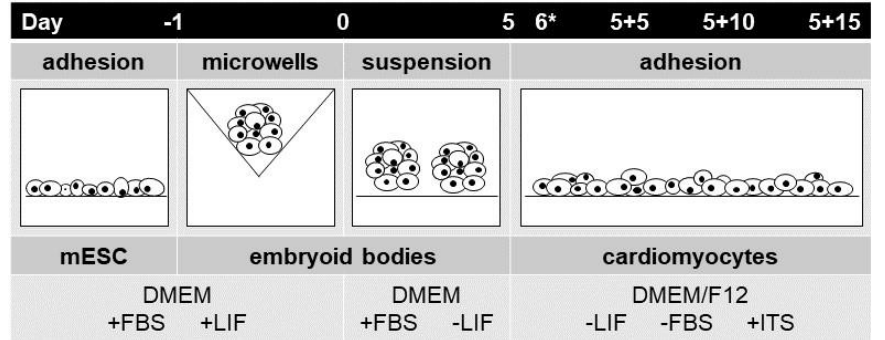
Figure 7. Schematic illustration of the protocol for differentiation of mESCs. For the preparation of EBs from mESCs, the silicone microwells were used. After 24 h of incubation (Day 0), the EBs were transferred onto an agar-coated dish. On day 5 (Day 5), the EBs were seeded to the 24-well stimulation platform. On day 6 (Day 6 *) cells were